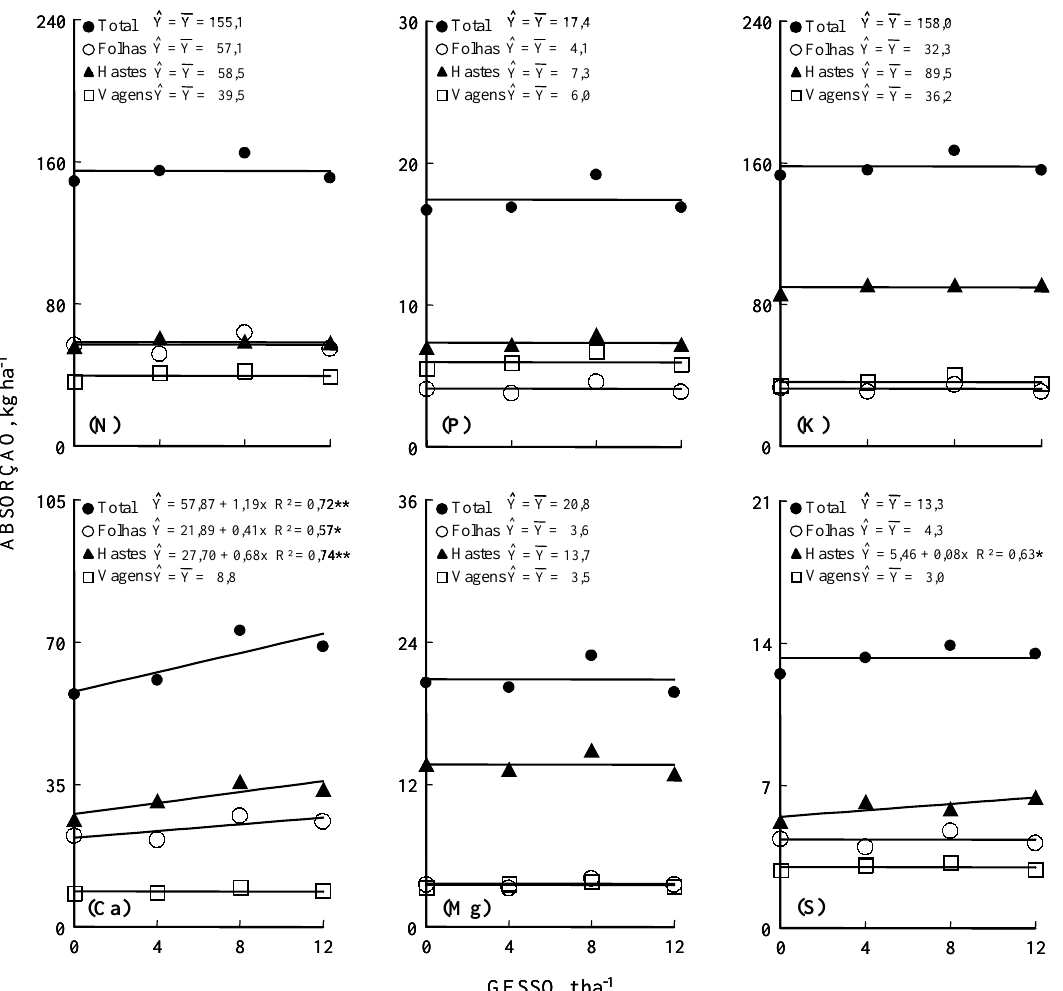
Figura 4. Efeito de doses de gesso na absorção de macronutrientes por diferentes partes da planta de soja. *, ** significativos a 5 e 1%,